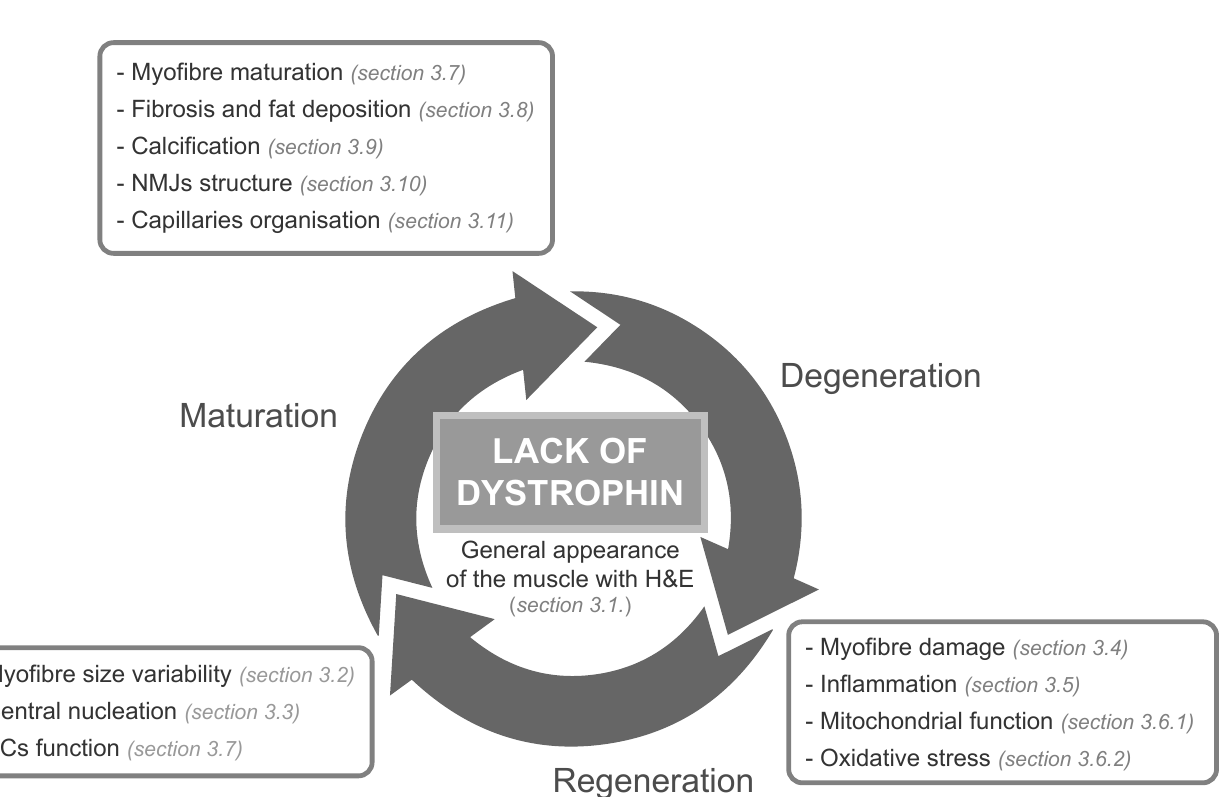
Figure 1. Histopathological examination in dystrophic muscles. Main events and processes that can be assessed through histological tests in muscles lacking dystrophin. These muscles go through multiple rounds of degeneration/regeneration/maturation, ultimately leading to impaired regeneration, chronic inflammation and replacement of muscle fibres with connective tissue, thus producing fibrosis, fat deposition and muscle wasting. Each of these events will be explained in the sections indicated in the